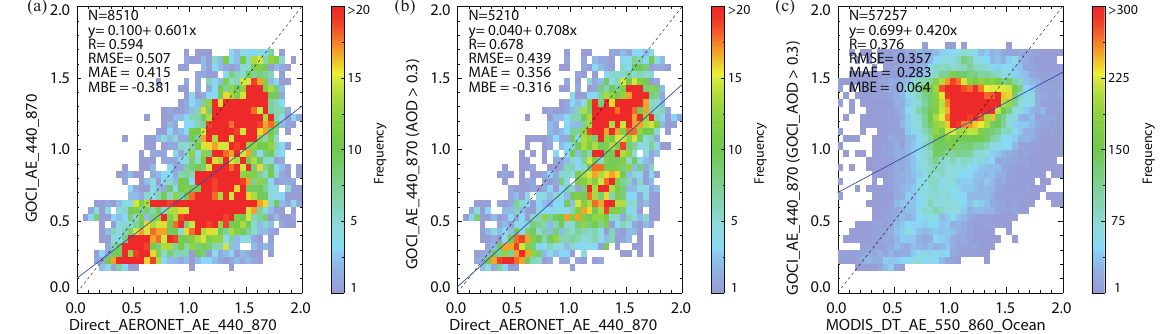
Figure 10. Comparison of AE between direct AERONET and GOCI for (a) the whole AERONET AOD range, and (b) only for AERONET AOD >0.3. (c) AE intercomparison between MODIS DT and GOCI over ocean only for GOCI AOD >0.3. Colored pixels represent a bin size of 0.05. Wavelengths of Ångström exponents are 440 and 870nm for AERONET and GOCI, and 550 and 860nm for MODIS DT over ocean. Dashed and solid lines denote the same as Fig. 9.